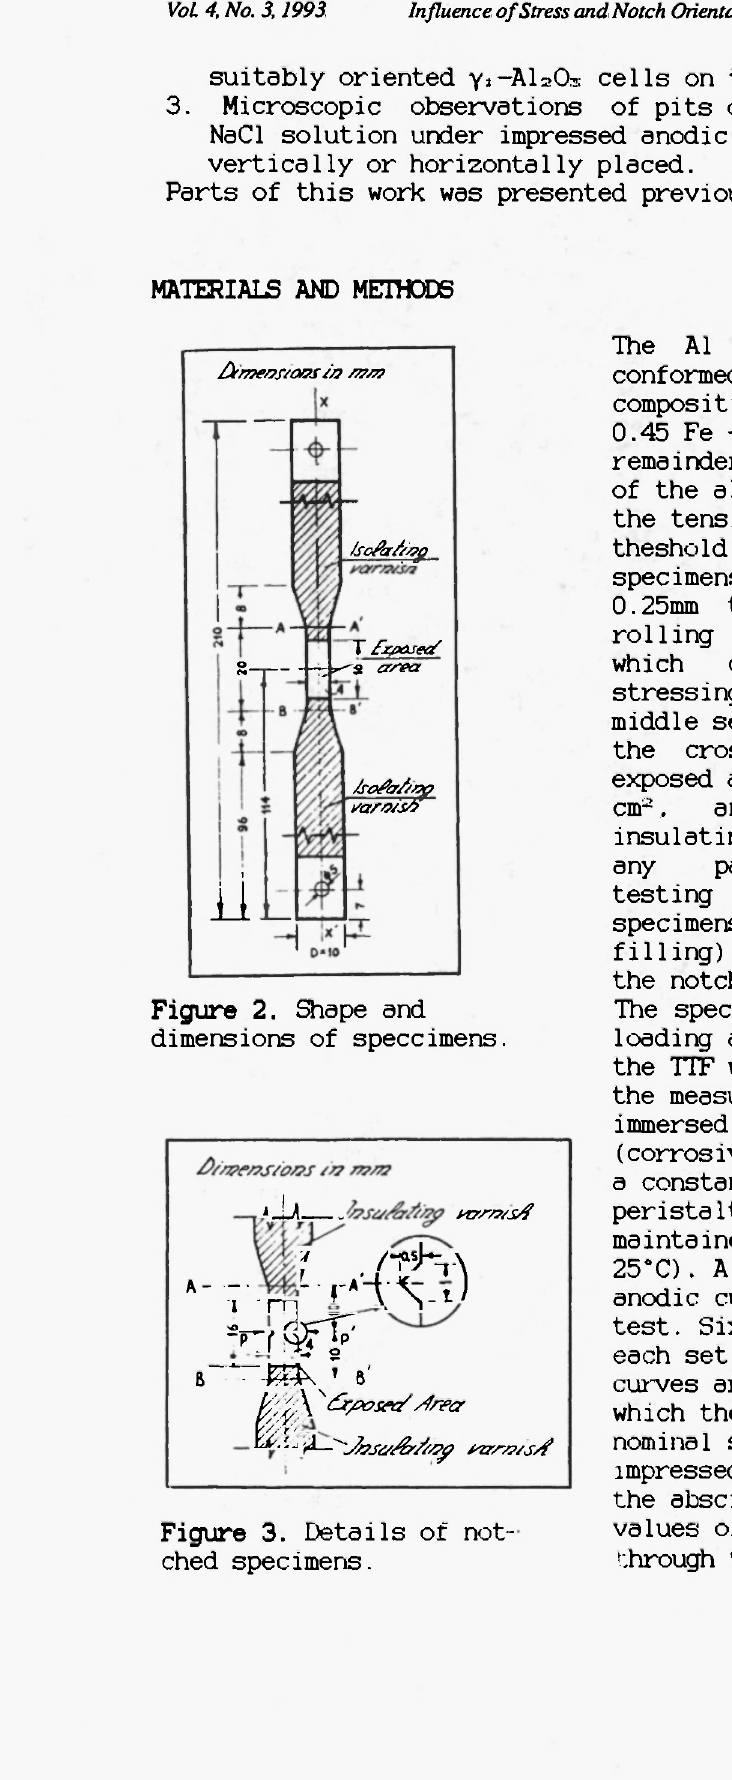
Figure 3. Details of not- ched